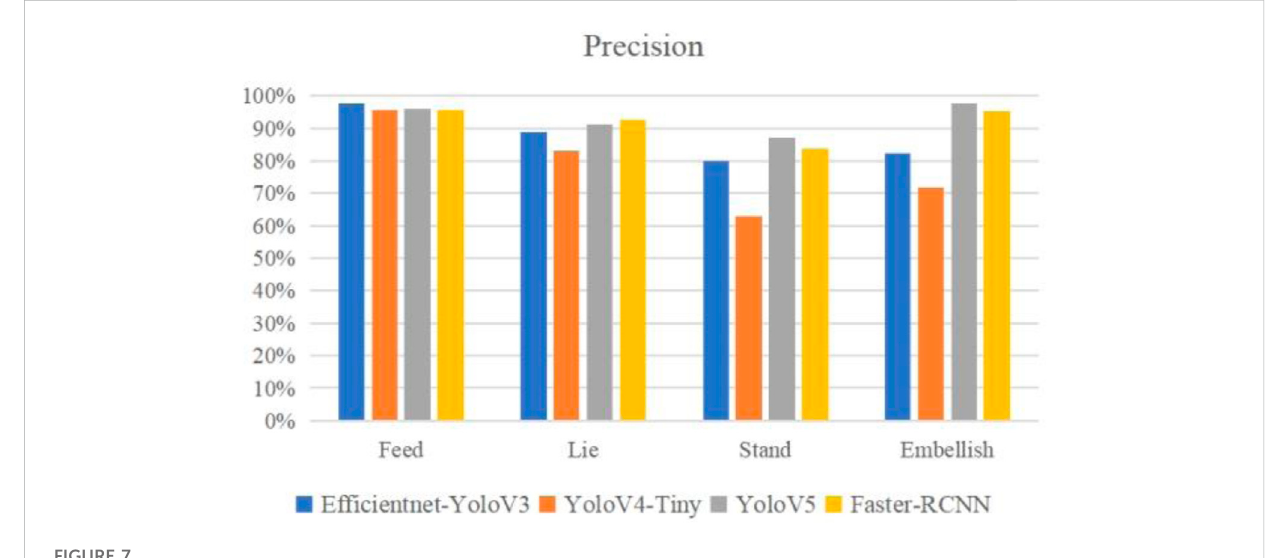
FIGURE 7 Comparison of the different algorithm Precision s for different behaviors.